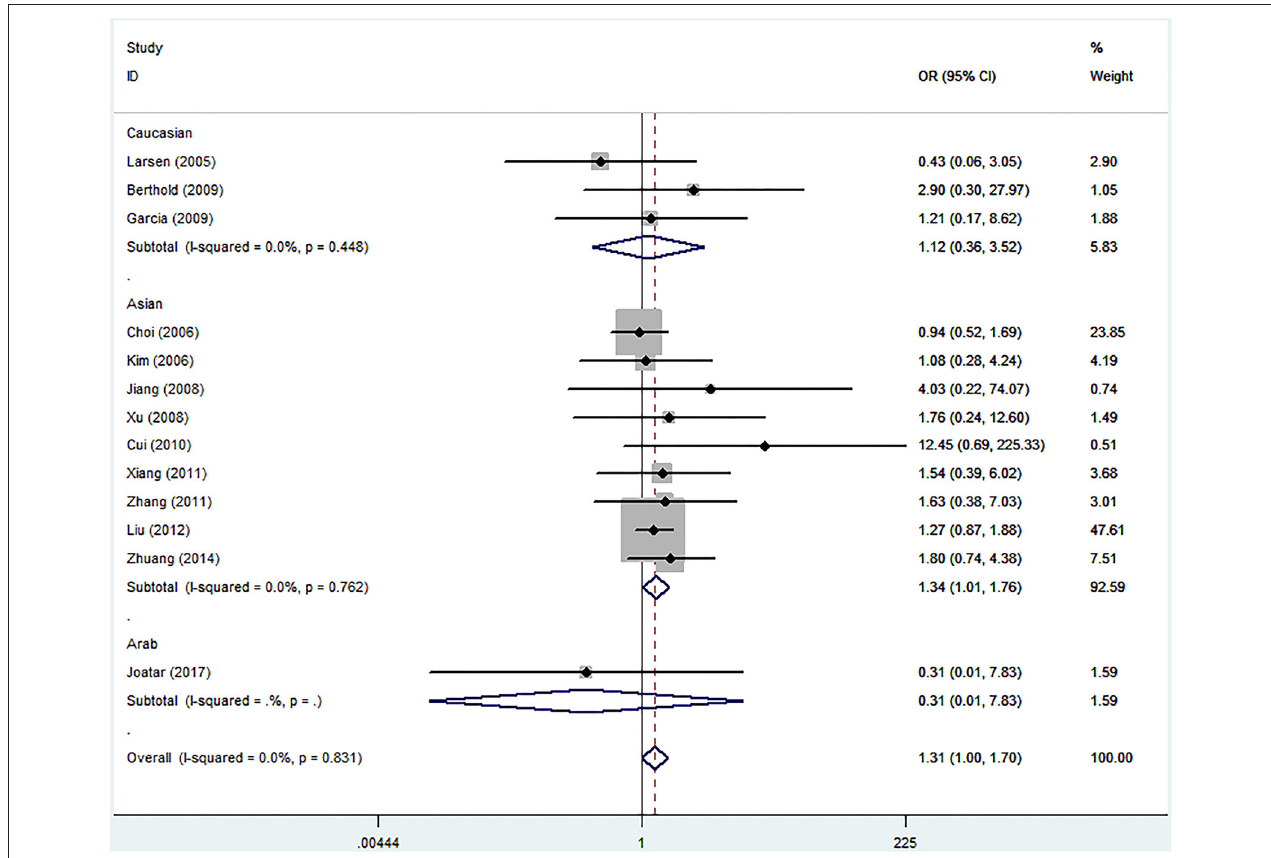
FIGURE 3 | Forest plots of ghrelin Leu72Met polymorphism and risk of type 2 diabetes mellitus in homozygous model (fixed-effects model) (OR = 1.307, 95%CI = 1.001–1.705, p = 0.049).